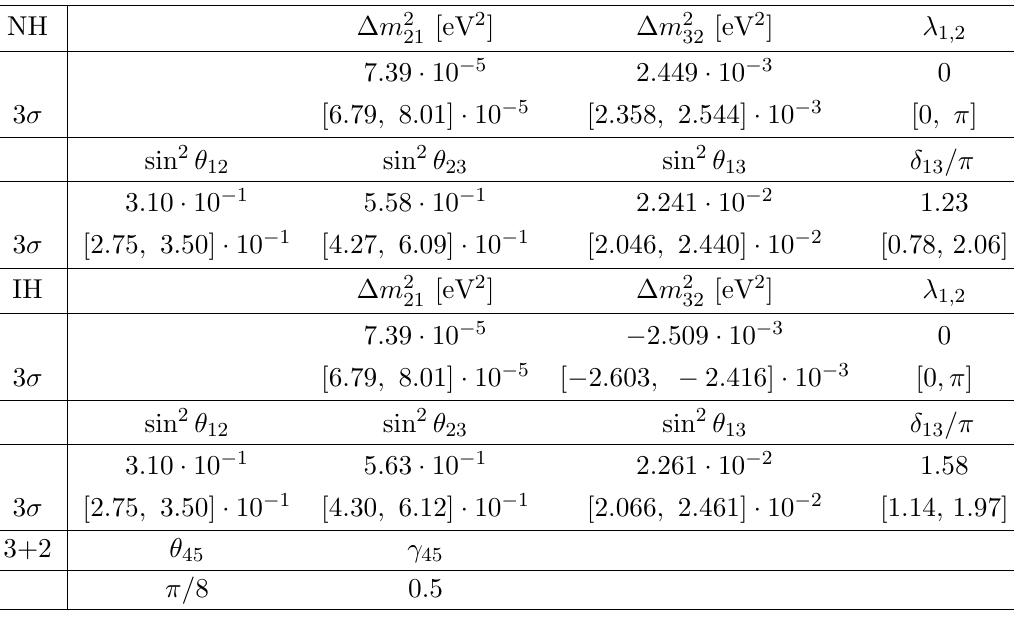
Table 10 . Input parameters used for the analysis of the standard three-light Majorana neutrino scenario, depicted in (cid:12)gure 6, and the 3 + 2 model. The values of the light neutrino mass splittings and the PMNS angles are taken from ref. [132].